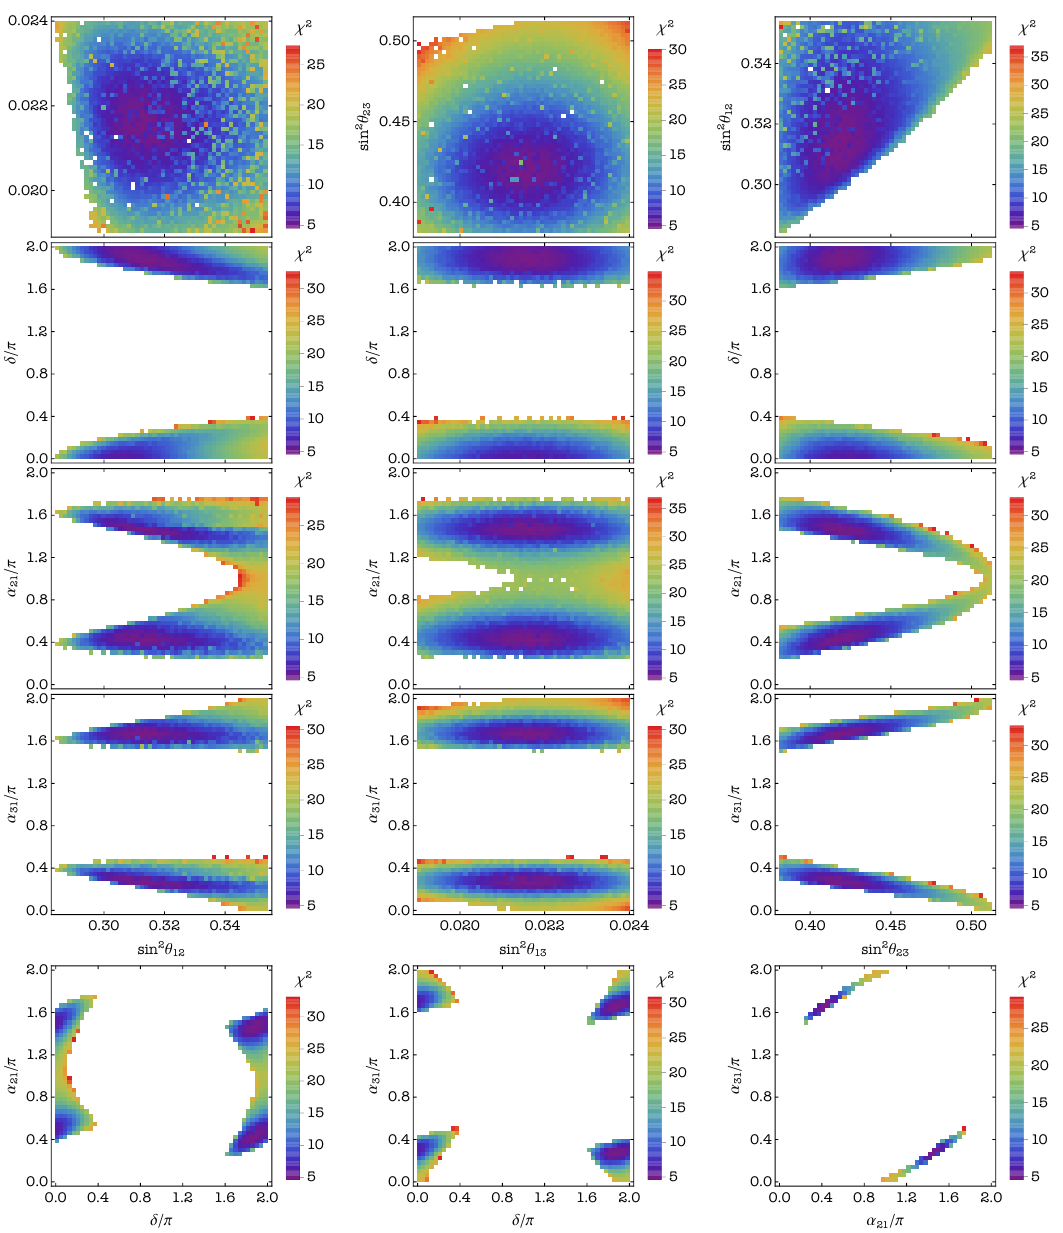
Figure 10 . Correlations between the neutrino mixing parameters in case D2. The values of all the three mixing angles are required to lie in their respective 3 (cid:27) ranges. Colour represents values of (cid:31) 2 for the NO neutrino mass spectrum.